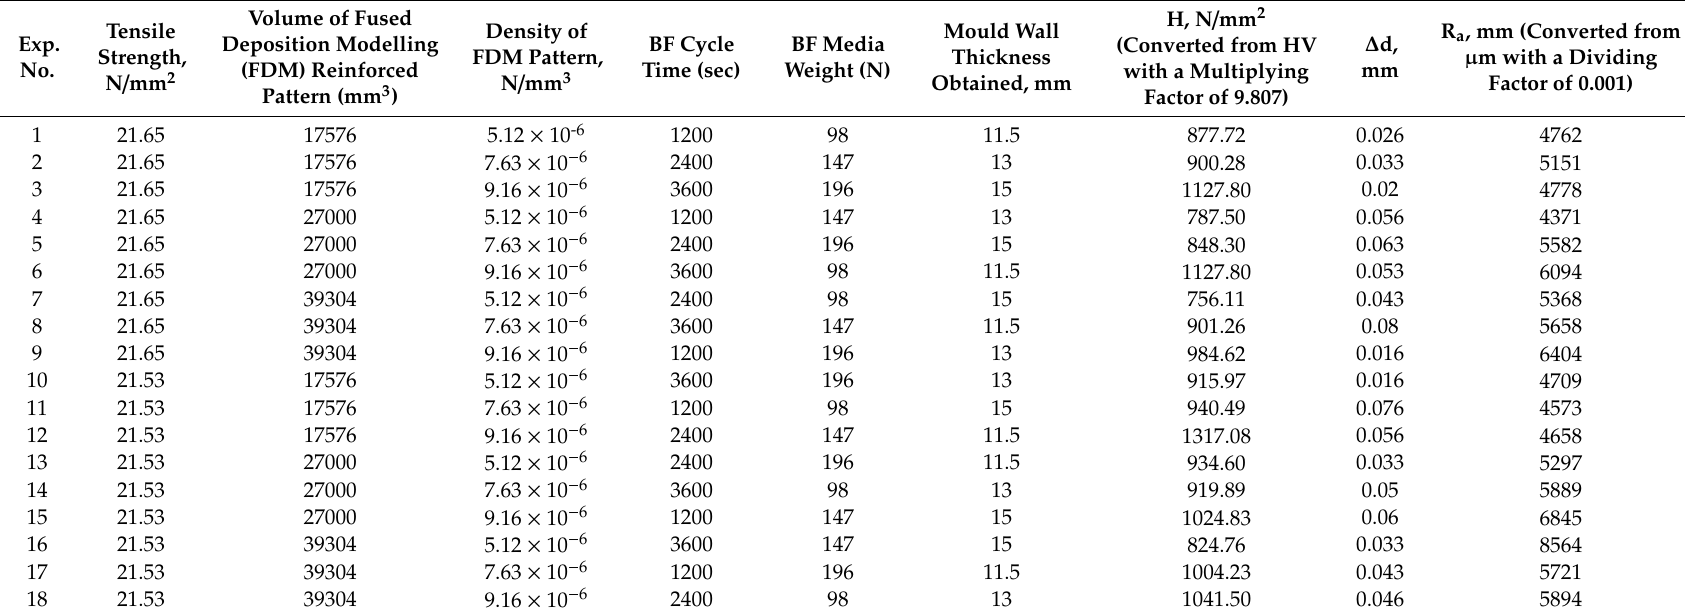
Table 1. Modified Taguchi L18 orthogonal